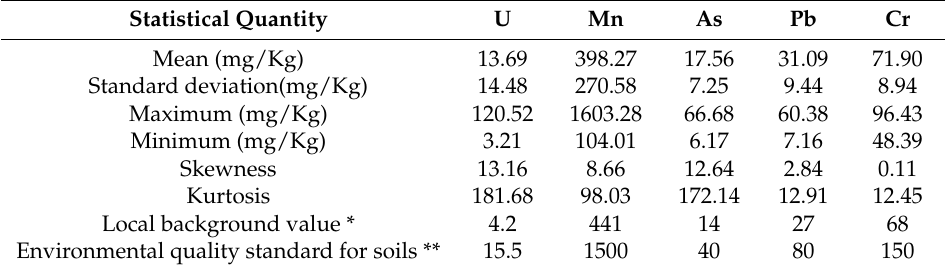
Table 1. Descriptive statistical summary of five target element concentrations in soil samples.